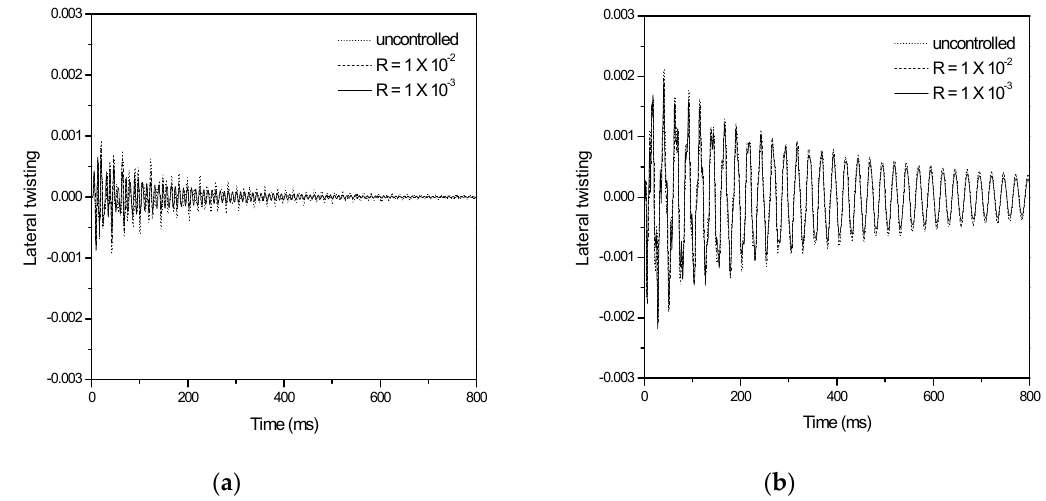
Figure 10. Lateral twisting responses with two locations of stiffener using LQR control: ( a ) Stiffener Case 1; ( b ) Stiffener Case 2.